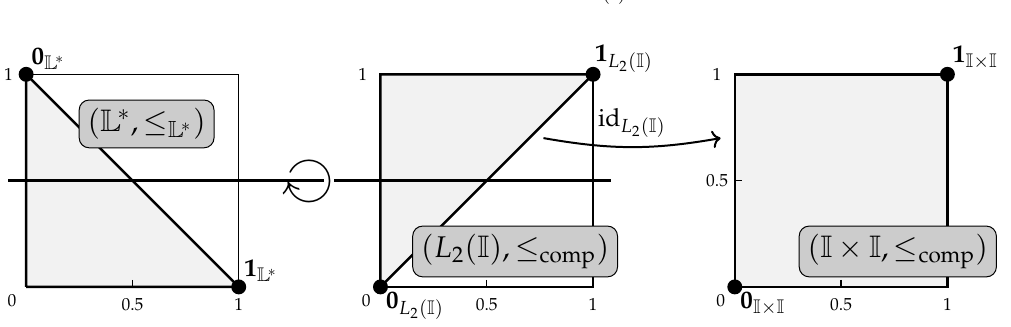
) ( center ), and ( I ) ( left ), ( L 2 ( I ) , Figure 2. The lattices ( L ∗ , ≤ L ∗ ≤ comp ) and ( L 2 ( I ) , mirror symmetry between L ∗ and L 2 ( I ) shows that ( L ∗ , ≤ L ∗ ) is a sublattice of ( I ) and ( L 2 ( I ) , I , ≤ comp × ≤ comp